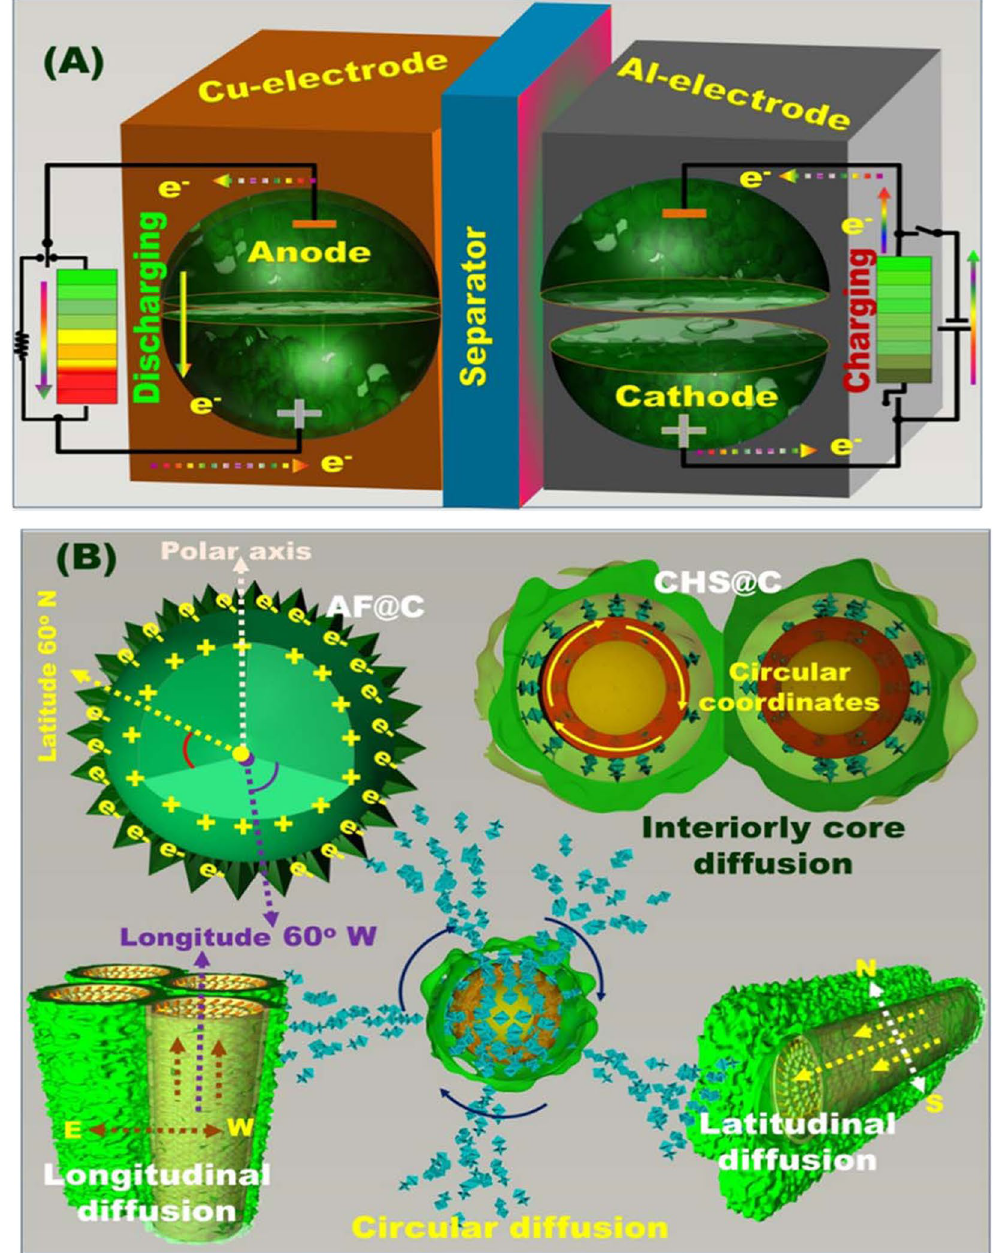
Figure 7. ( A ) Systematic design of long-term lithiation/delithiation (discharge/charge) cycling. ( B ) Interior/ exterior hollow electron/ion diffusion pathways along the 3D mesopores, hollow cavities, open-mouth sinks, axial directions, and axis coordinates of hierarchy AF@C decorated with meso-geodesic cavity and needle dendrites along the 3D anisotropic hollow surfaces and HCS@C cathodes. ( A , B ) Full-scale LIB cell configuration of TiO 2 @C (PHV@C, anode)//LFPO@C (cathode) electrodes markedly guided for excellent long-term cycle stability for 2000 cycles at rate of (1C). In full-cell LIB design fabricated with full 3D hollow orientation of anode/cathode, the structural hierarchy model with a bundle of upward/outward spheroid- capped gradients designed in different surface curvatures and multi-accessible directions, including zigzag, helical, circular, latitudinal, and longitudinal axis, offers the key clues for the capacity retention of LIBs. The continuous function and stability of transport pathways of electron/Li + ions movements after 2000 cycles and simultaneous trapping/detrapping of Li + ions during the lithiation/delithiation (discharging/charging) cycling for full-cell-based (PHV@C) (anode)//(LFPO@C) (cathode) were